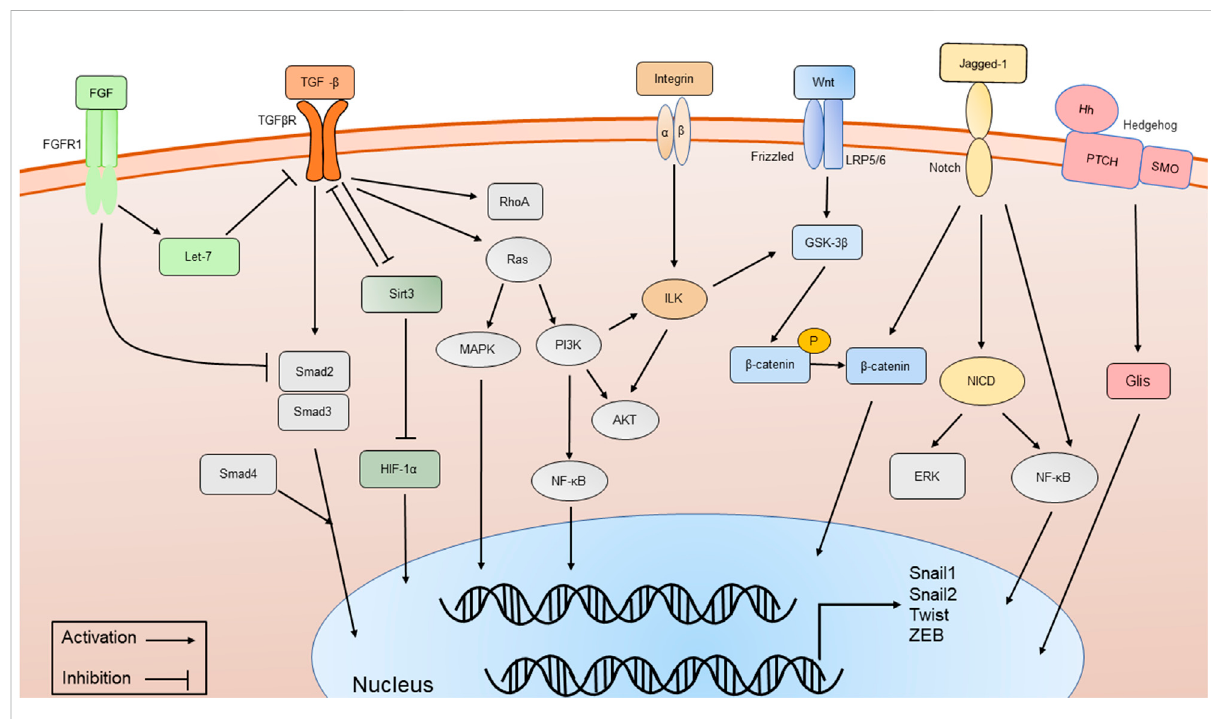
FIGURE 2 The major signaling pathways involved in phenotypic transitions, including TGF- β /Smad-dependent and Smad-independent signal transduction pathways, Wnt/ β -catenin signaling pathway, Integrin/ILK signaling pathway, Notch signaling pathway, Sirt3 signaling pathway, FGFR1 and Hedgehog signaling